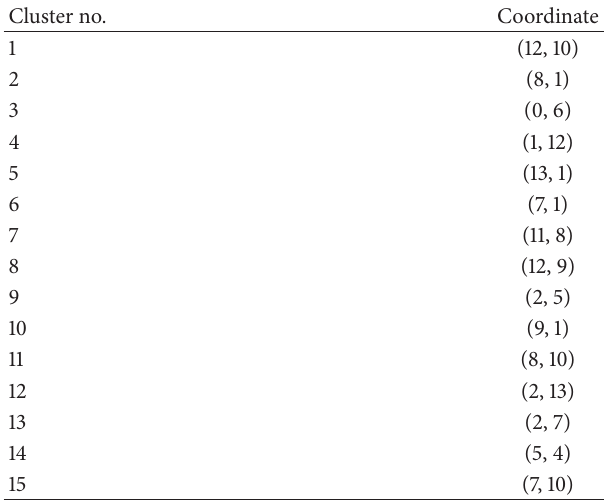
Table 1: Results of random